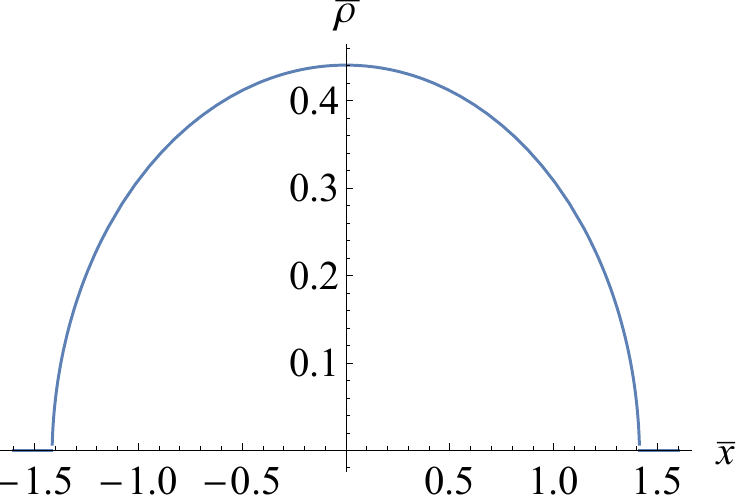
Figure 3. Dimensionless 1D number density ¯ ρ from Equation (23), for interaction strength ¯ g = 10 − 2 and normalization constant ¯ A = 1/ ( 2 π )